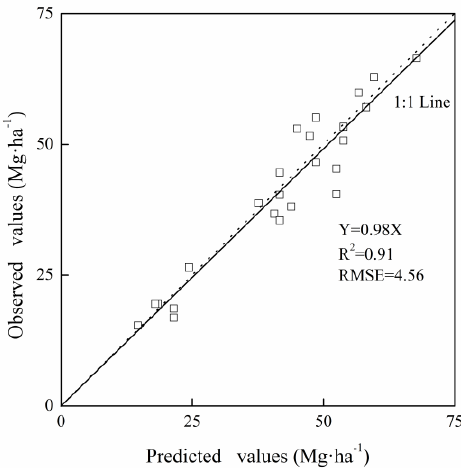
Figure 6. Relationship between the observed and predicted yields of the exponential yield prediction model for estimating in-season yield of